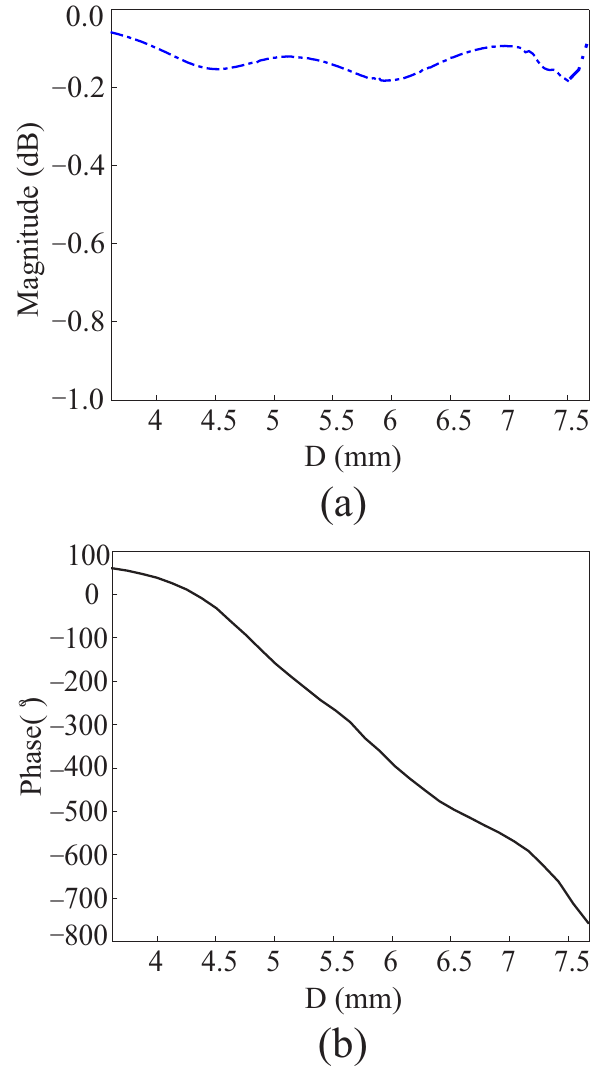
Figure 2. Floquet port simulation of the unit cell at 11.725 GHz: ( a ) Magnitude of the reflection coefficient. ( b ) Phase of the reflection